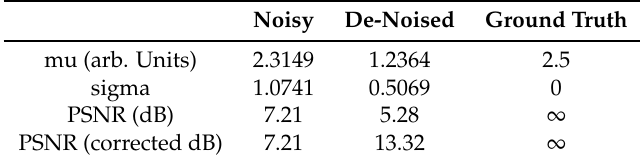
Table 1. Statistics for multilayer perceptron (MLP) denoising in Figure